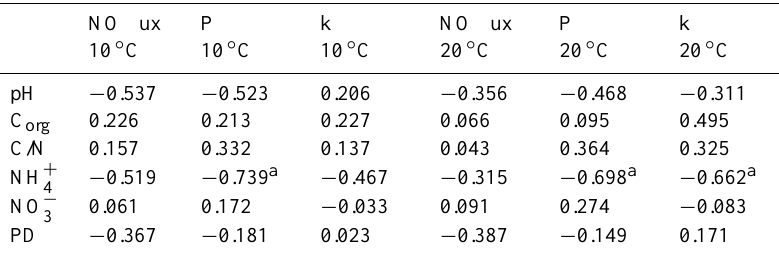
Table 4. Results of Pearson product moment correlation analysis of net NO release rates, net potential NO flux, NO production rate ( P ) and NO consumption coefficient ( k ) versus physical and chemical soil